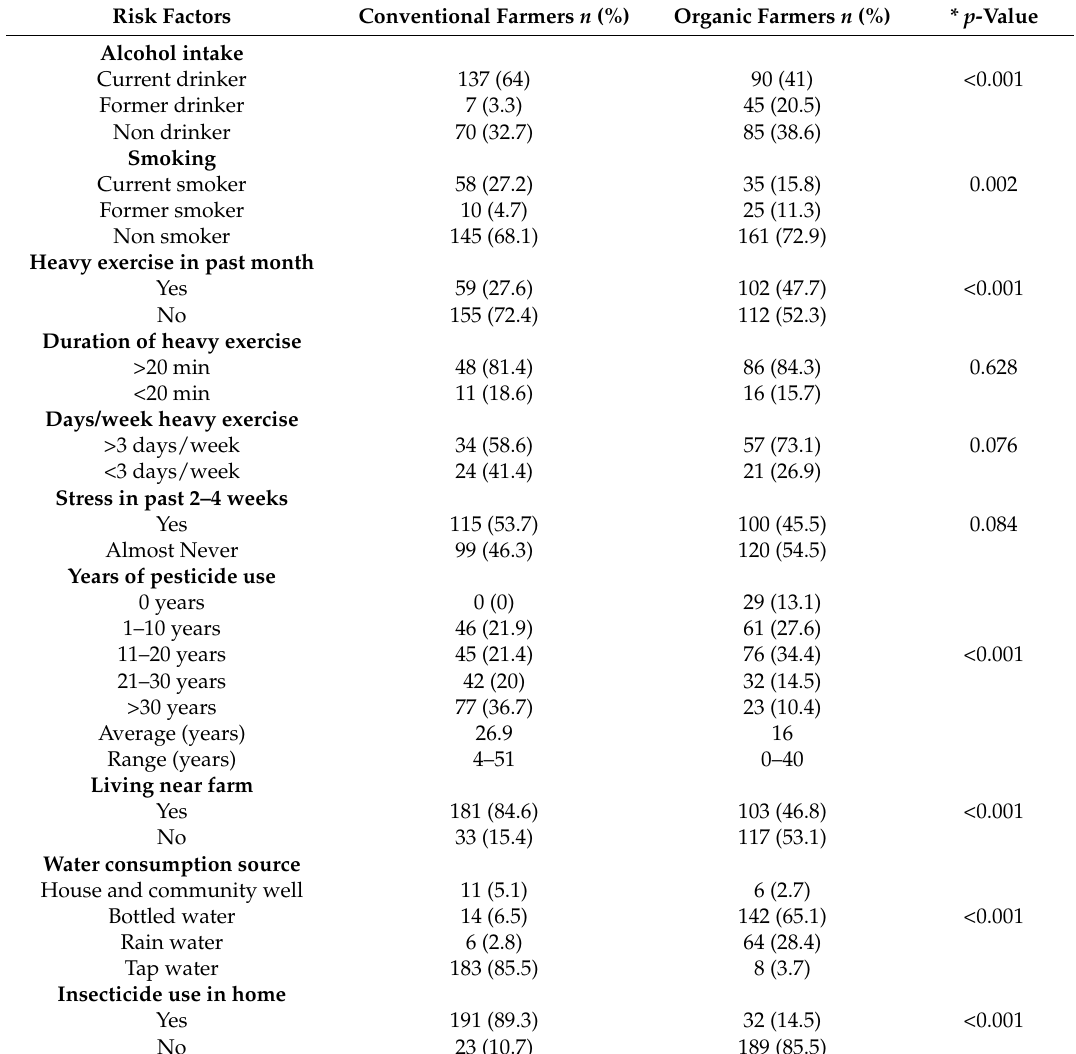
Table 2. Risk factors between conventional farmers ( n = 214) and organic farmers ( n = 222). Risk Factors Conventional Farmers n (%) Organic Farmers n (%) * p